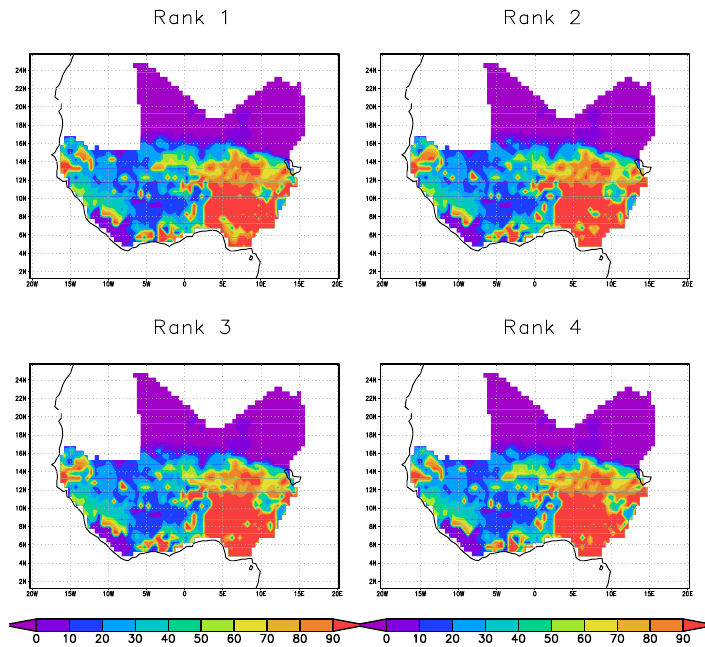
Figure 7. Future crop area coverage (%) in West Africa as projected by the LandPro algorithm under the MIROC-driven climate, following four different ranks of prioritizing crops in land allocation: Rank 1, descending order of country-level crop deficit (initial run); Rank 2, ascending order of country-level crop deficit; Rank 3, maize, sorghum, millet, cassava, peanut; Rank 4, peanut, cassava, millet, sorghum, maize.